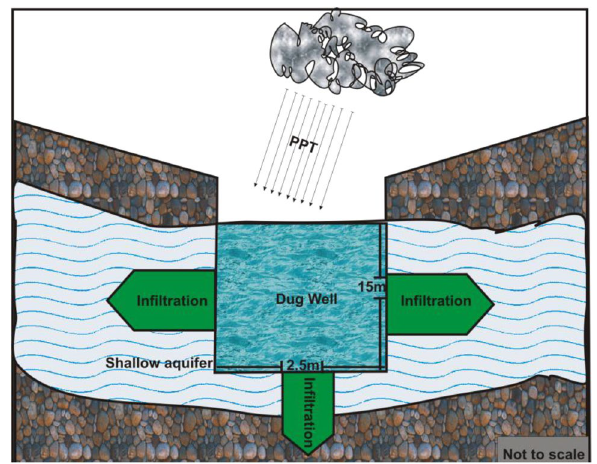
Fig. 2 Schematic representation of shallow aquifer recharge mecha- nism from SDWs